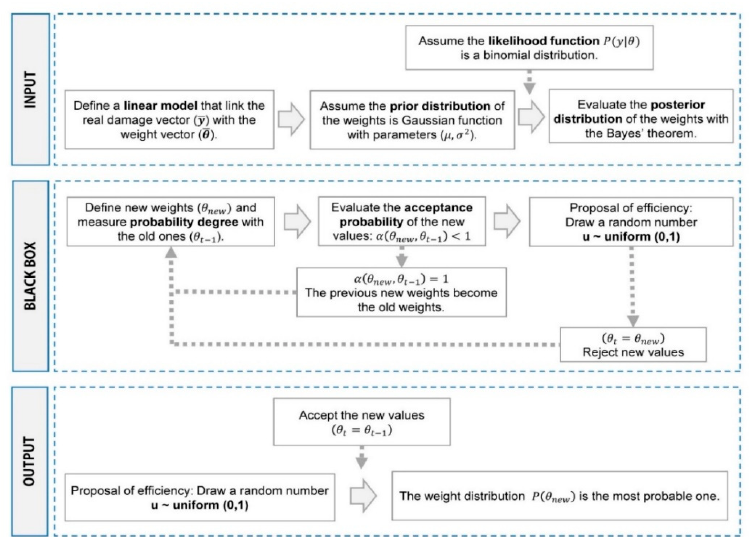
Figure 17. Procedure followed for the identification of the weight distribution.